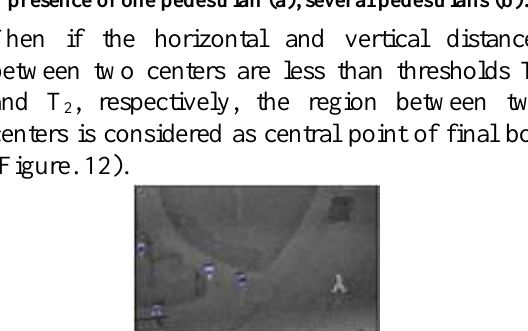
Figure 11. Center detection of ROIs with possibility of presence of one pedestrian (a), several pedestrians (b).